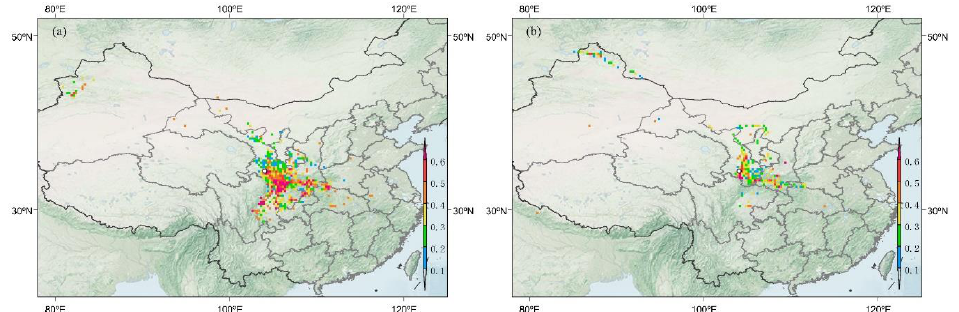
Figure 9. The potential evaporation source area of Minxian Station in the summer half-year ( a ) and winter half-year ( b ).